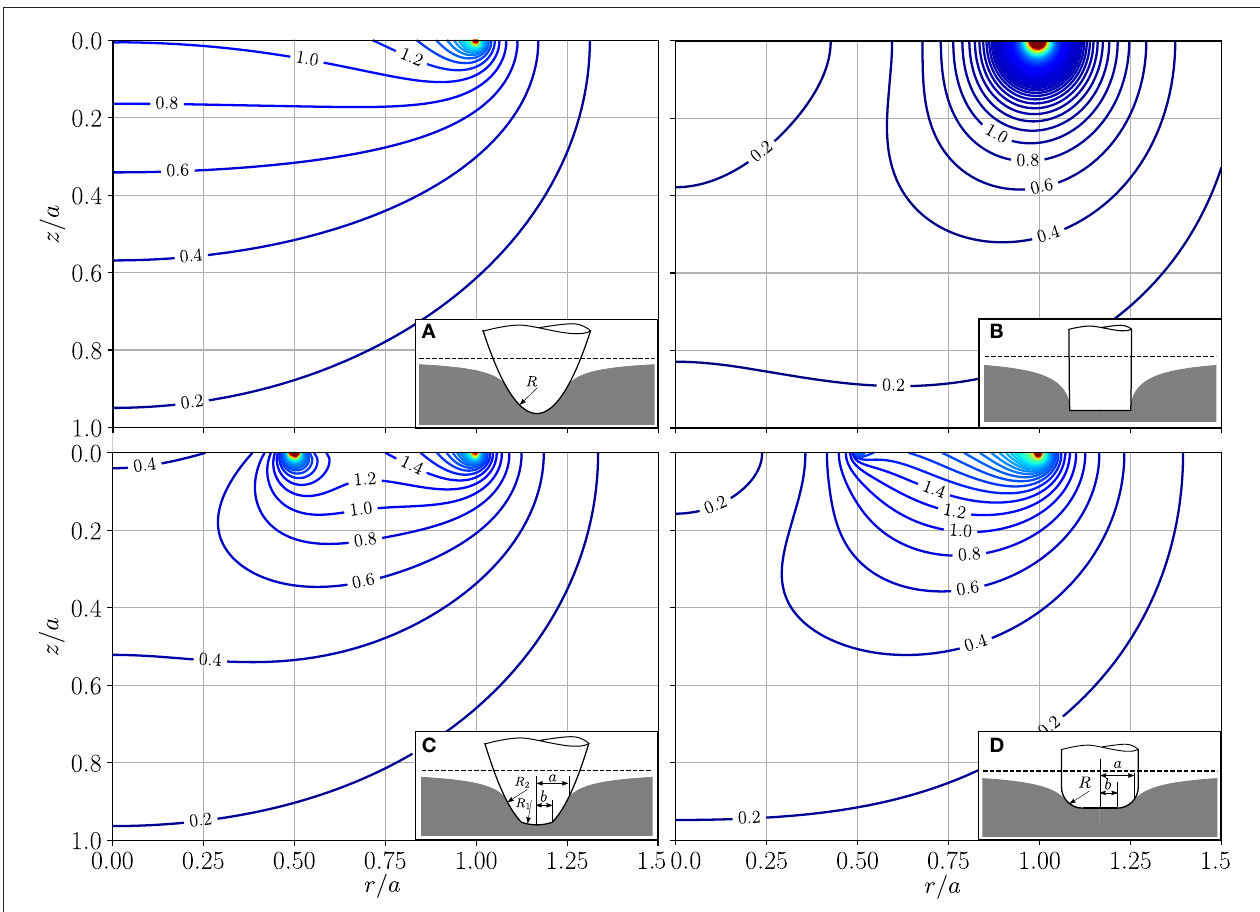
FIGURE 2 | Normalized absolute value of the hydrostatic pressure gradient assuming ν indenter, (B) Cylindrical flat punch, (C) paraboloid with a parabolical cup with b / a